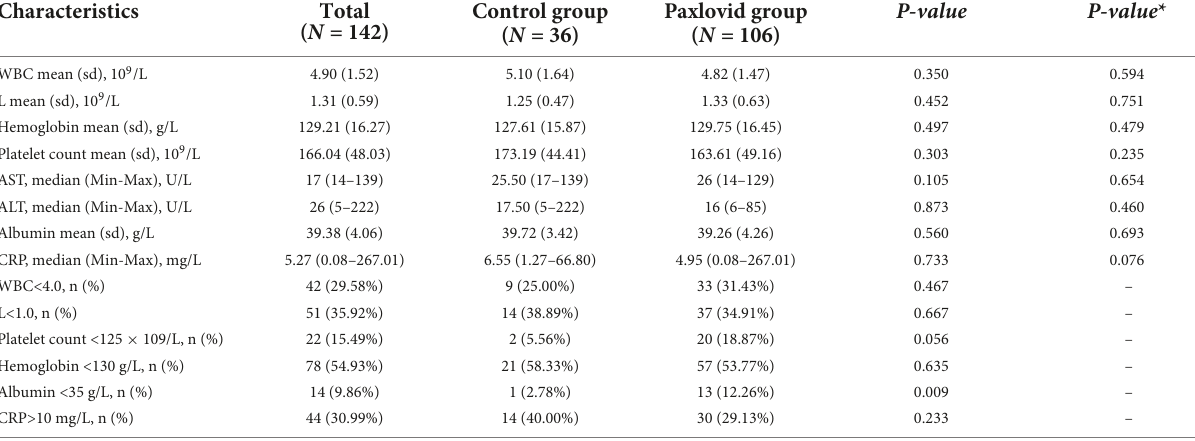
TABLE 2 Laboratory results of patients with COVID-19 at enrollment and after treatment. Characteristics